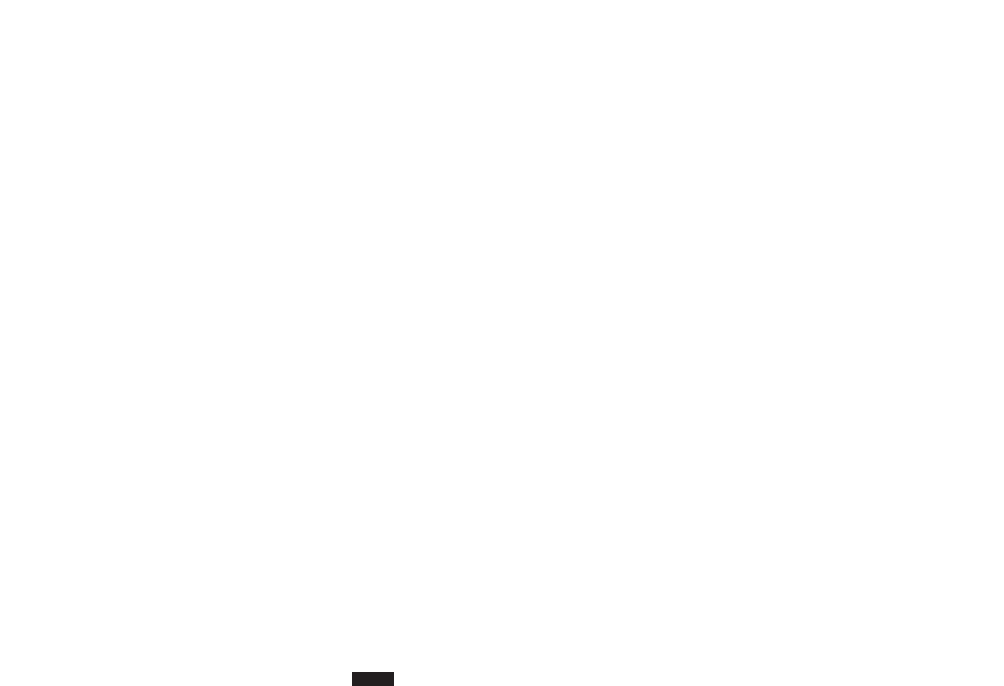
FIGURE 1-A1(Continues...): Questionnaire – Non-attending eye theatre